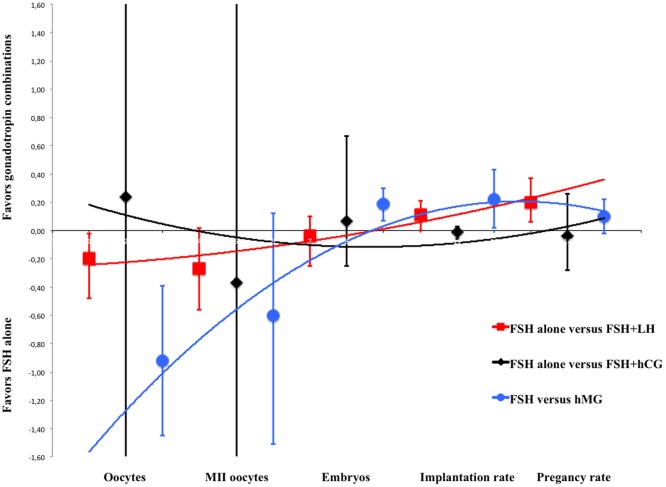
Overall model of meta-analysis results. Each scatter plot represents the mean differences with related confidence interval (95%) for each of assisted reproductive technology outcomes evaluated. The three lines represent the polynomial trend line. Red line shows the results with luteinizing hormone supplementation, blue line with human menopausal gonadotropin and black line with human chorionic gonadotropin.